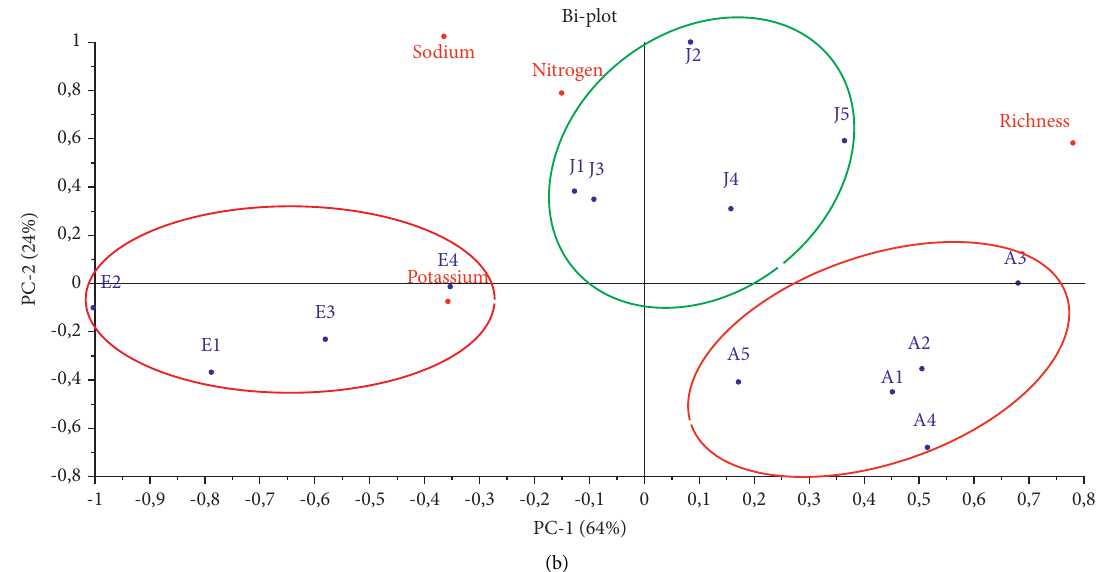
Figure 2: Biplot (PC1 vs. PC2) of analyzes of beet quality parameters and samples in 3 harvest dates: (a) in the raw state; (b) on standardized centered